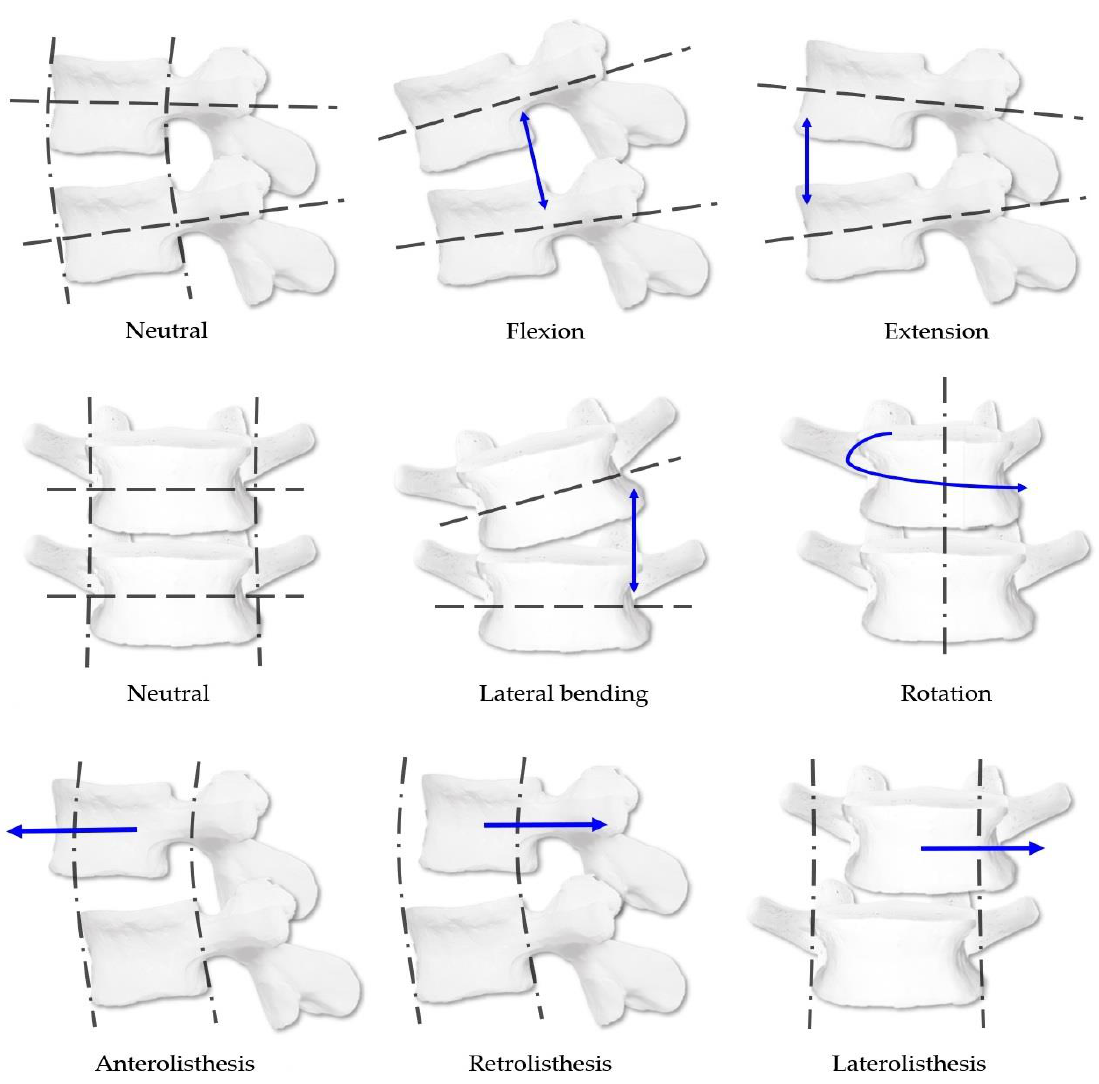
Figure 2. Classification system of spinal malposition and listhesis diagnosis in Chuna manual therapy. The blue arrow indicates how it changes from the neutral position according to the types of malposition or listhesis. Copyright 2022. Jin-Hyun Lee all right reserved.